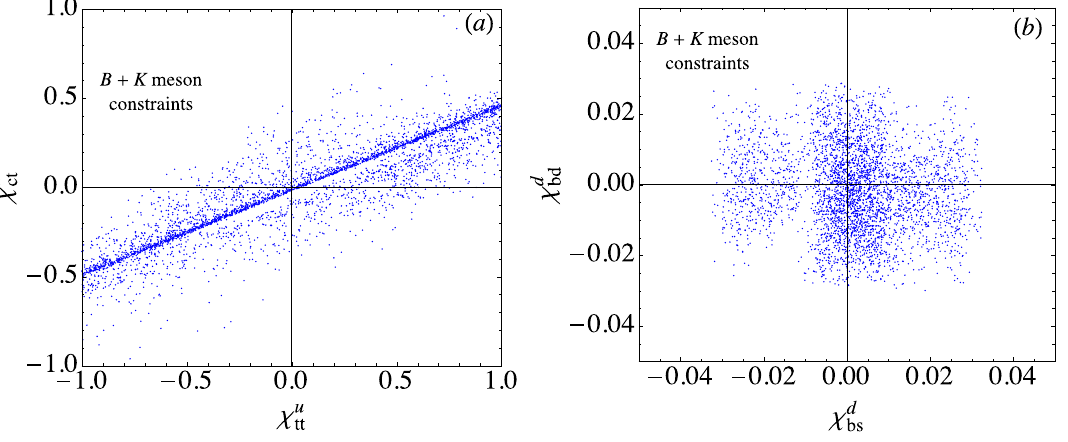
and B X s (cid:13) , where the plots (a) and (b) denote the d ;B s ! and (cid:31) u and the allowed ranges of (cid:31) d and (cid:31) d , respectively. The number of tt ct bs bd 10 6 . (cid:1)